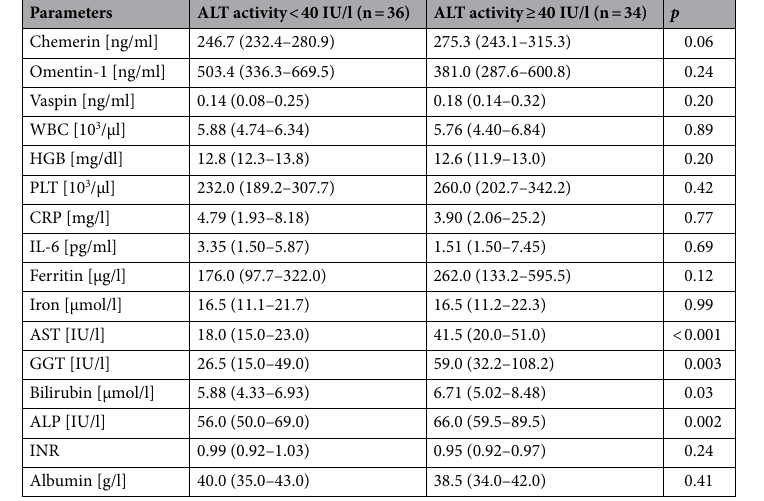
Table 4. Comparison of COVID-19 patients with different ALT activity.